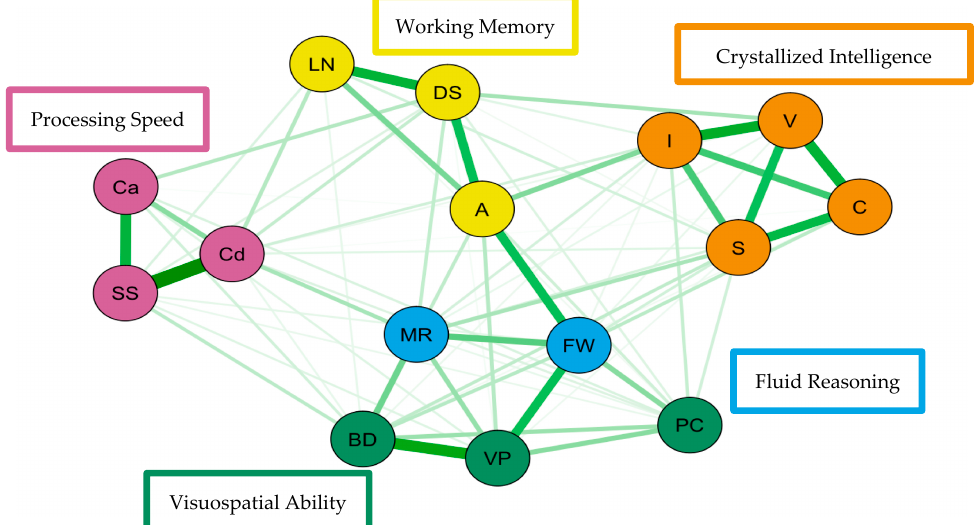
Figure 3. Weighted, undirected network model of the Hungarian Wechsler Adult Intelligence Scale Fourth Edition estimated using qgraph. Green edges indicate positive partial correlations. For simplicity, nodes have been colored to reflect the latent structure of the higher-order latent variable measurement model and the width of each line represents the amount of association between pairs of nodes. The network models reveal four to five clusters of nodes. Three of the clusters are distinct, representing working memory, processing speed, and crystallized intelligence. The distinction between fluid reasoning and visuospatial ability is less clear. Also, in both network models, working memory and fluid reasoning are more central to the network than the other clusters.